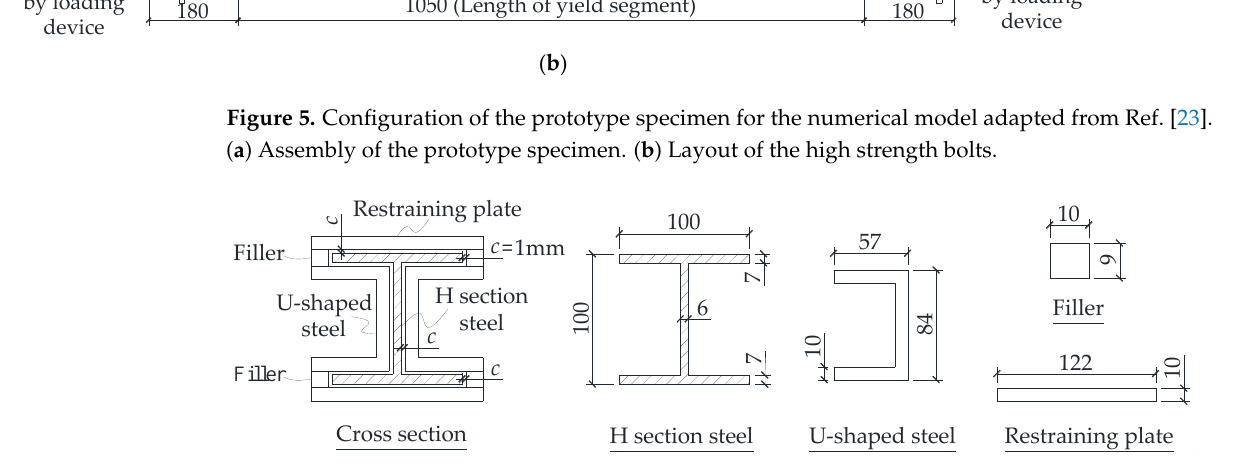
Figure 6. Detailed geometric dimensions of the numerical model (Unit: mm).